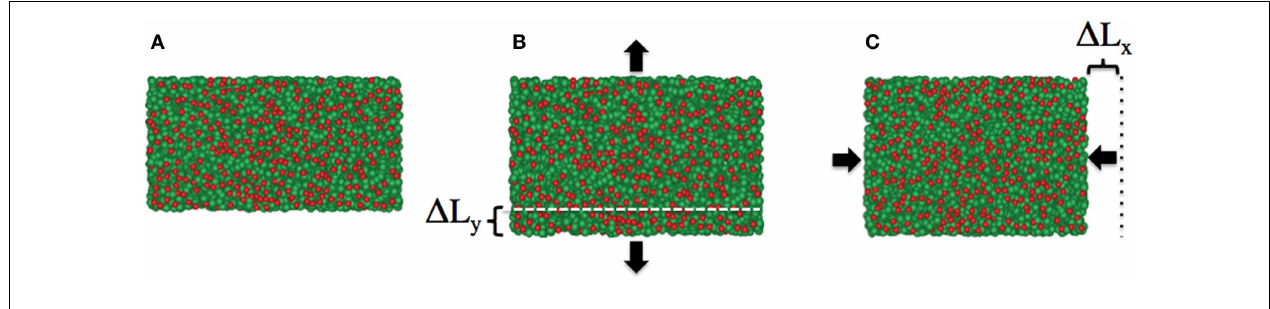
consequence of positive Poisson’s ratio for the bilayer in this phase, the membrane size in x -direction is reduced and equilibrated after a few number of MC steps. Lipid’s head beads and tail bead are shown in red and green, respectively.